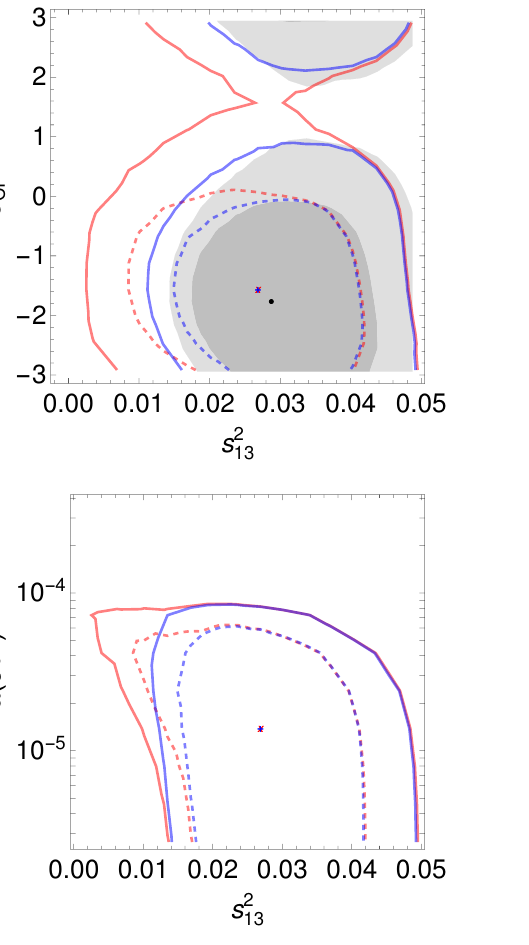
(cid:0) (cid:1) m 2 subspace. We (cid:12)nd that 23 32